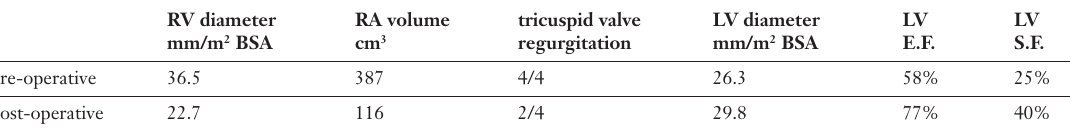
Table 1 Echocardiography parameters (mean